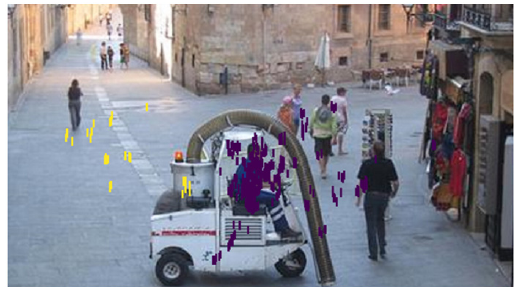
Figure 14. Image No. 3 which denotes the classification results of the SVM method in [10]. Similarly, the results of the test data are statistically analyzed and the gaze points classification results of 100 gaze images are evaluated. Figure 15 presents the average comparison of test experimental results.